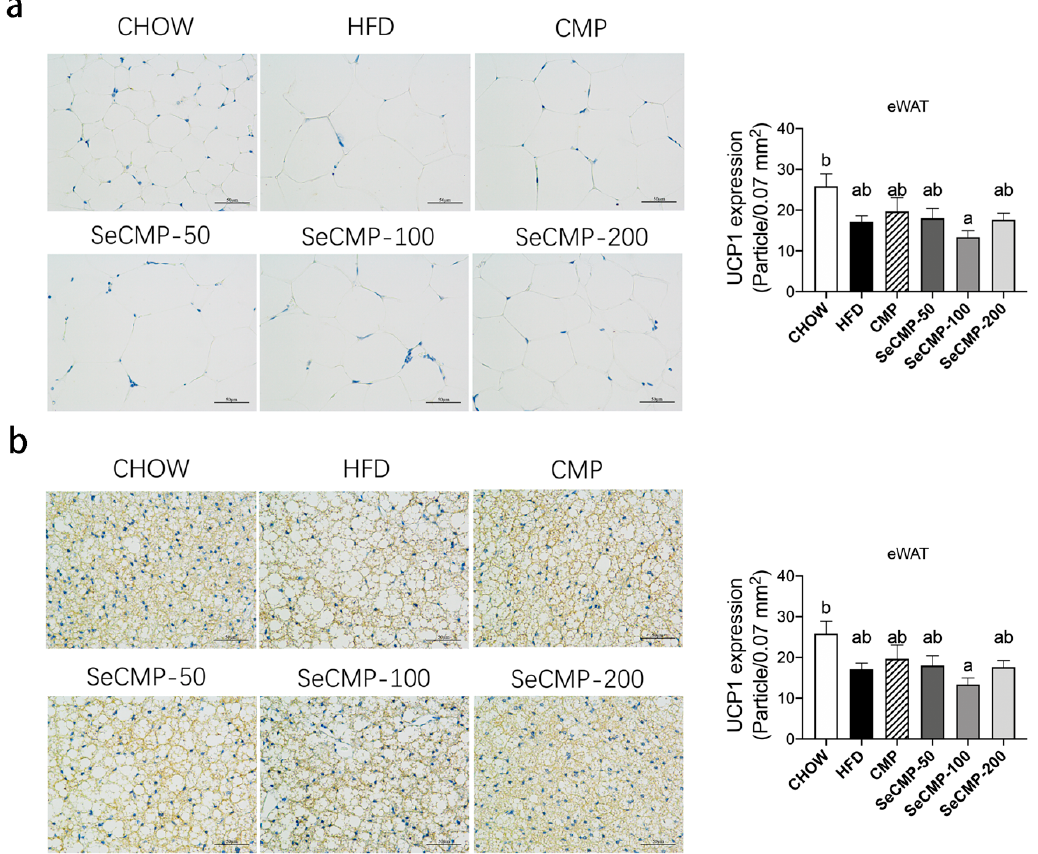
Figure 4. Administration of selenium-rich C. militaris crude polysaccharides (SeCMP) improved thermogenic of high-fat diet (HFD)-induced obese mice. ( a ) UCP1 protein expression density in eWAT; ( b ) UCP1 protein expression density in BAT. Scale bars, 50 µ m. Data represent mean ± SE (n = 6–8 mice/group). Superscript characters in panel ( a , b ) indicate significant variation among treatments. CHOW: normal diet + sterile water; HFD: high-fat diet + sterile water; CMP: high-fat diet +100 mg/kg selenium-deficient C. militaris crude polysaccharides; SeCMP-50: high-fat diet +50 mg/kg SeCMP; SeCMP-100: high-fat diet +100 mg/kg SeCMP; SeCMP-200: high-fat diet +200 mg/kg SeCMP.